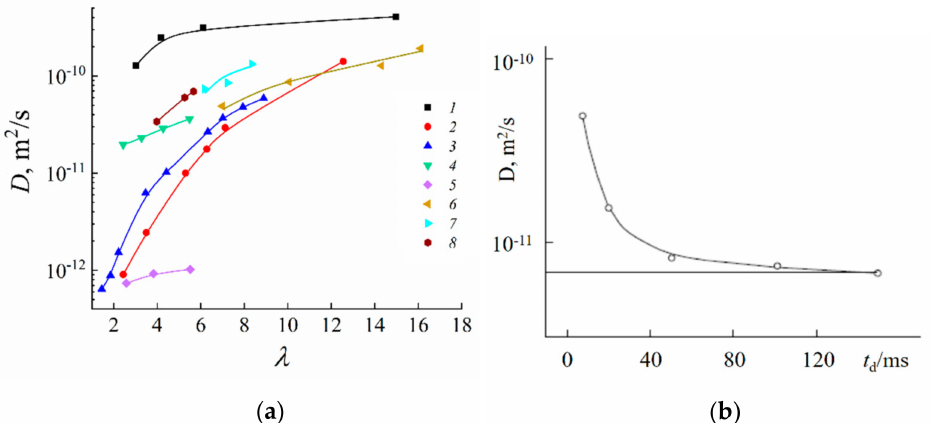
Figure 27. ( a ) Diffusion coefficients of water molecules dependence on the moisture content for sulfonate cation-exchange MF-4SC (1–4) and carboxylic F-4CF (5–8) perfluorinated membranes in various ionic forms. ( b ) Diffusion coefficients dependence of water molecules and hydrated H + counterions in the acidic form of F-4CF membrane on the diffusion time, relative humidity is 95% ( b ). Membrane ionic forms: (1, 5) H + , (2, 6) Li + , (3, 7) Na + , (4, 8) Cs + . Reprinted with permission from [20]. Copyright 2011